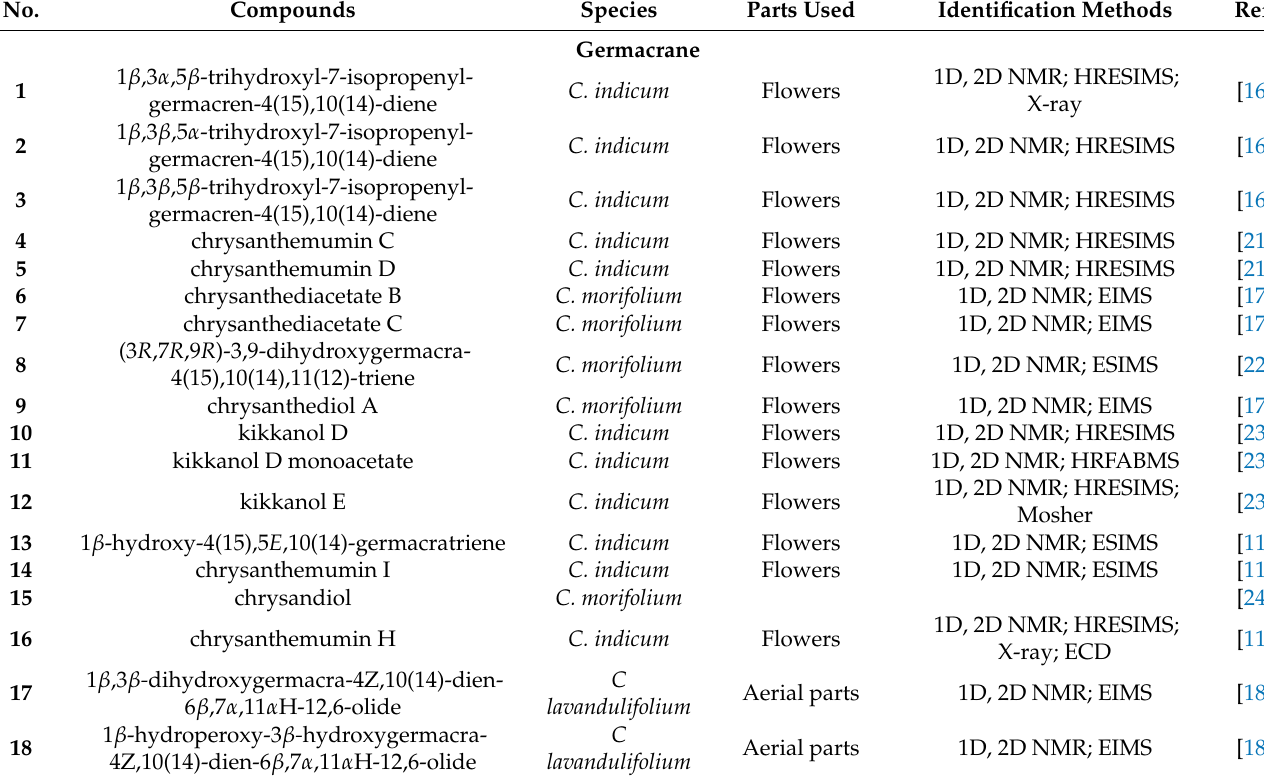
Table 1. Sesquiterpenoids from the Chrysanthemum